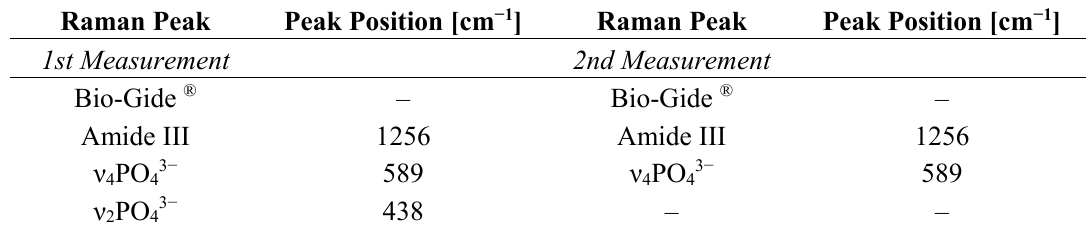
Table 2. Raman images and Raman correlation maps removed from the data